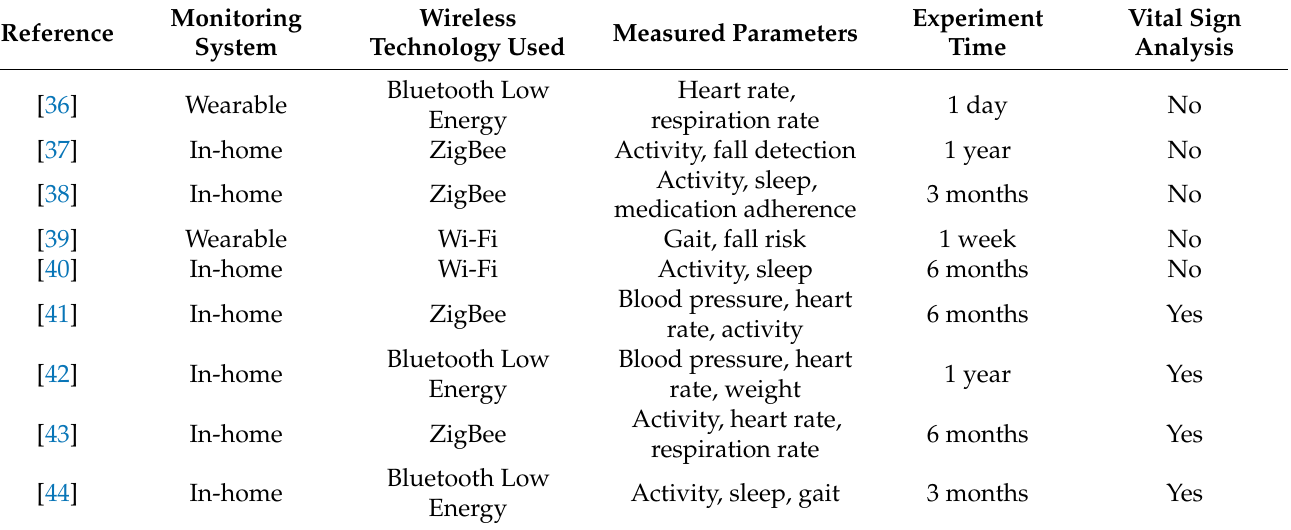
Table 1. Comparison of related works and current paper references on monitoring of older people with wireless sensor